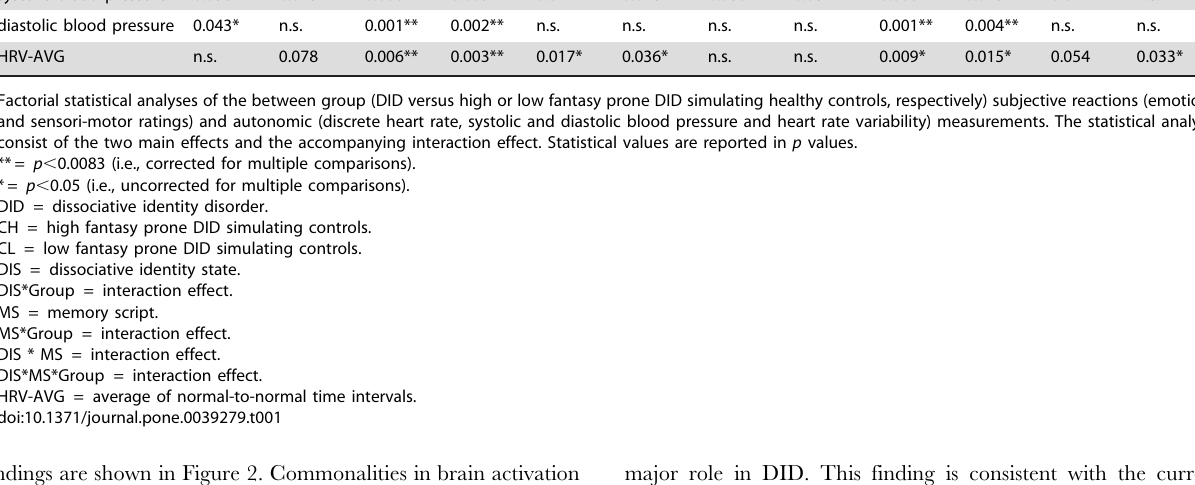
MS = memory script. MS*Group = interaction